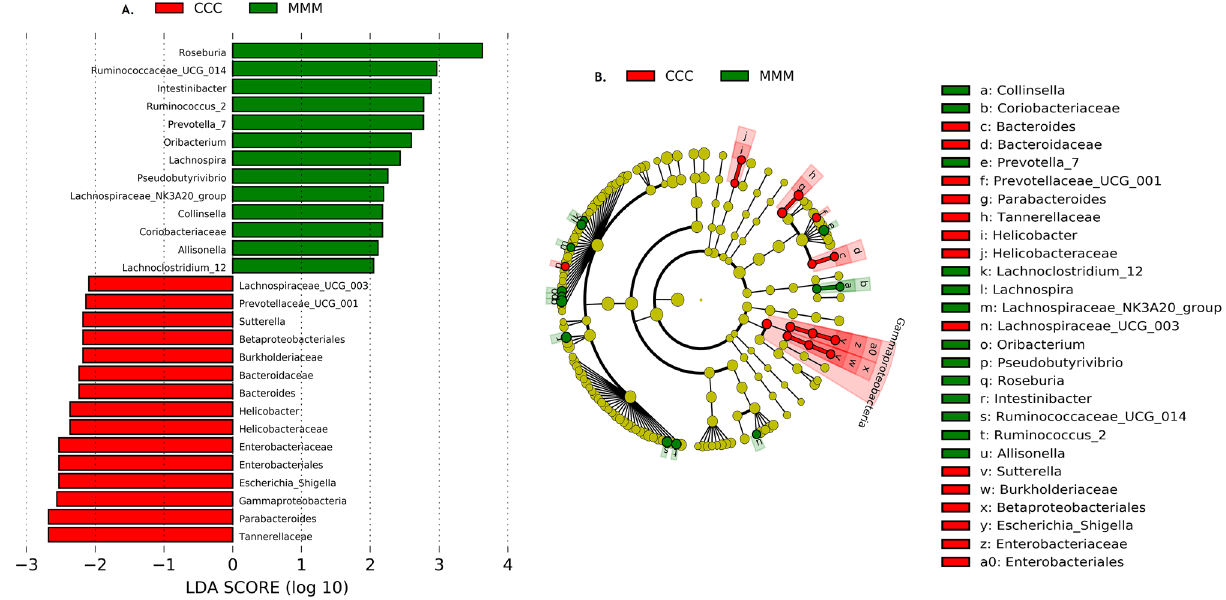
Figure 6. Linear discriminant analysis (LDA) effect size (LEfSe) of gut microbiota between control (CCC) and treatment (MMM) groups. ( A ) bar plot showing the differentially abundant taxa between groups, and ( B ) cladogram showing differences in abundant taxa between groups. LDA score threshold was > 2.0.